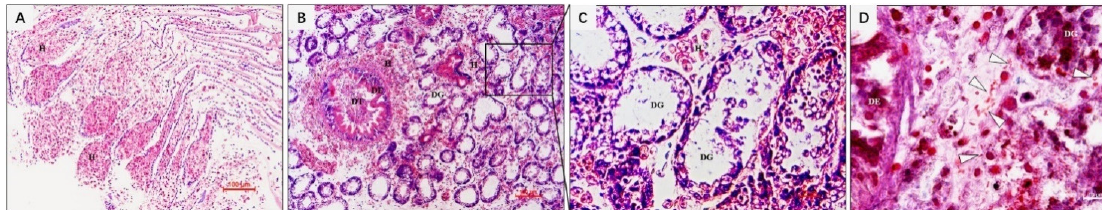
Figure 2. Histopathological changes of natural diseased ark clam tissues. ( A ) Eroded gill tissue with massive hemocytes infiltration. ( B ) Hepatopancreas with massive hemocytes infiltration, digestive epithelium with extensive necrosis. ( C ) Glandular tubule with erosion, severe vacuolization of epithelial cells. ( D ) Gram-negative bacteria in the connective tissue around digestive tubes and glands. H, hemocyte; DE, digestive epithelium; DT, digestive tubule; DG, digestive gland. Bar in ( A , B ): 100 μ m; bar in C and D: 10 μ m.